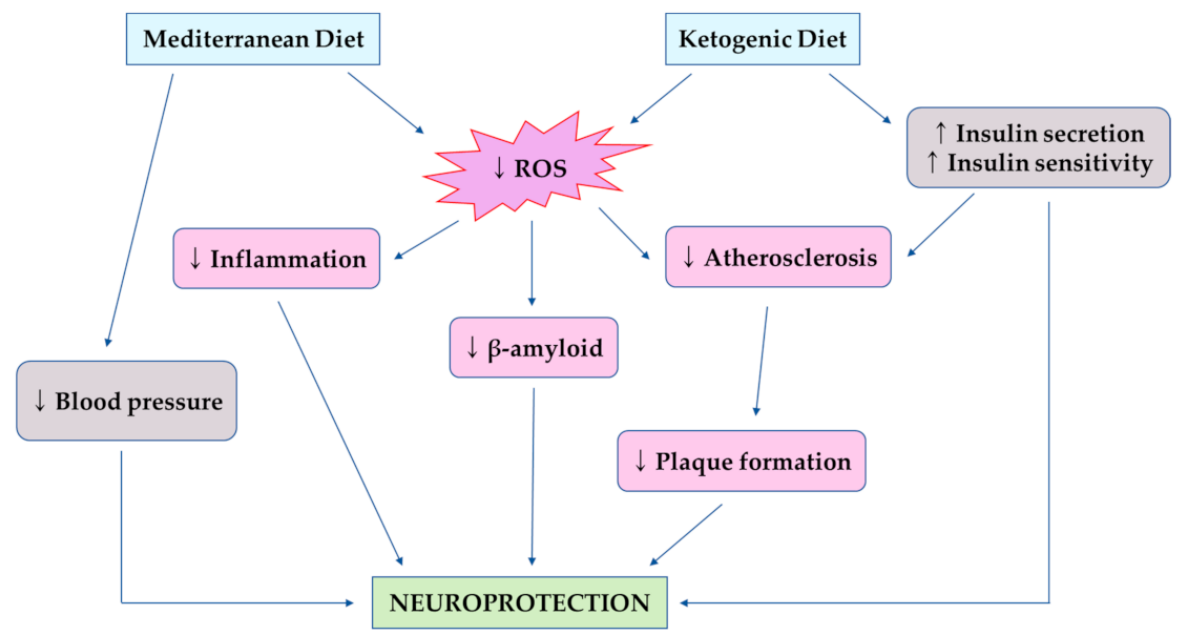
Figure 5. Protective effects of the Mediterranean diet and ketogenic diet on brain health and cognitive function [117]; ↑ , increase; ↓ ,